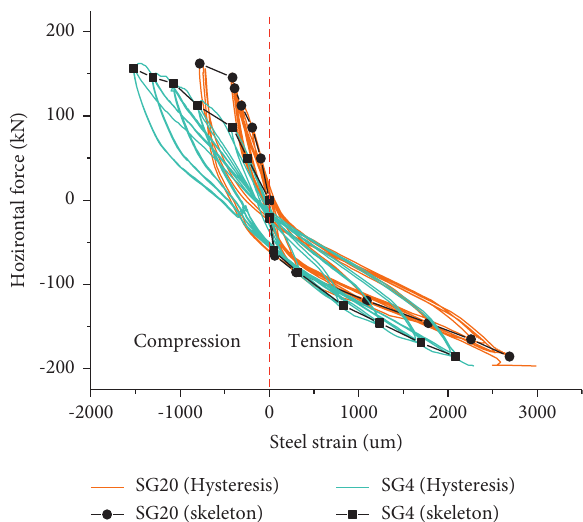
Figure 20: Hysteresis and skeleton curves of rebar strains above and below the type-I sleeve in YZ1.